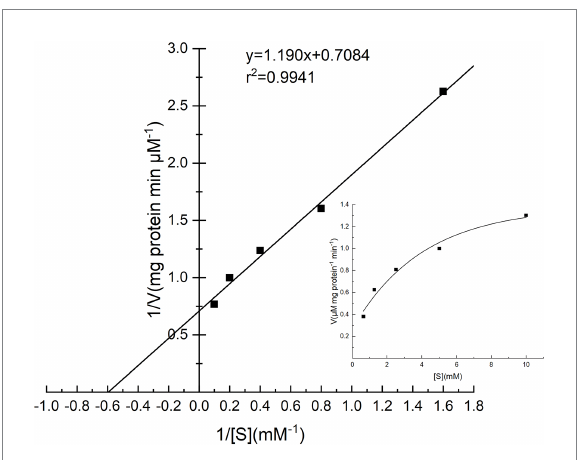
FIGURE 7 Lineweaver–Burk plot for the determination of K m and V max for PG from Chryseobacterium cucumeris